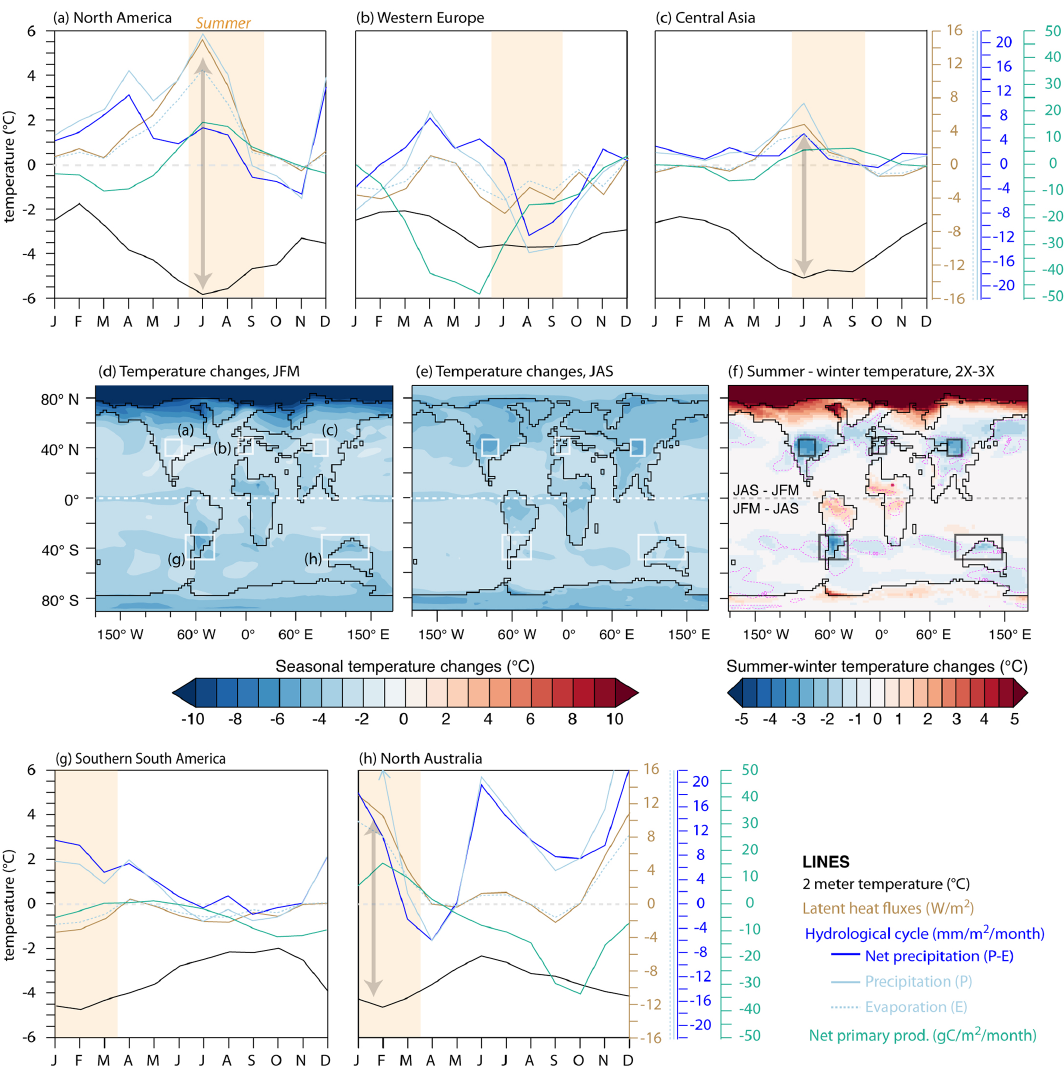
Figure 6. Annual variability of multiple climate parameters within the different areas of decreasing seasonality between 3 X and 2 X ( a–c , g , h ): atmospheric temperature (black), latent heat fluxes (soil to atmosphere; brown), hydrological cycle (including precipitation, evaporation and net precipitation; different shades of blue) and net primary productivity (green). Temperature changes and summer − winter temperature changes (d–f) . Rectangles outline the land areas analyzed in (a)–(c) , (g) and (h) (ocean zones are not taken into account in the calculation of the plots). Gray arrows show where decreasing summer temperatures match increased latent heat